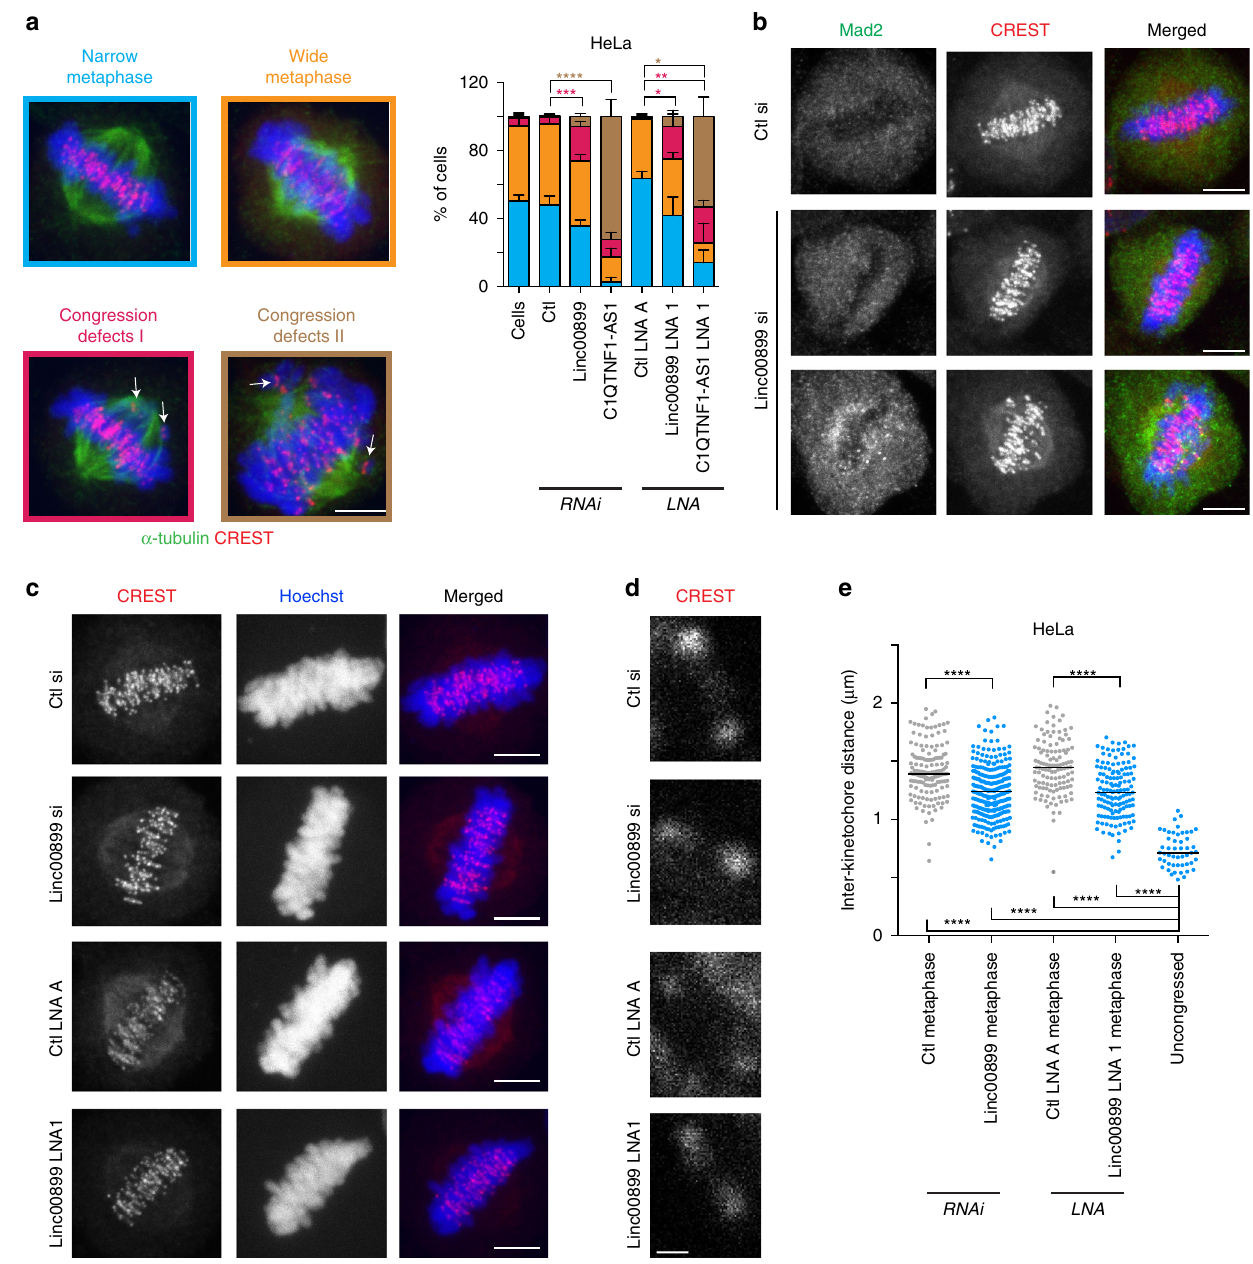
Fig. 6 Depletion of linc00899 causes chromosome congression defects. a Characterisation of mitotic phenotypes in HeLa cells after RNAi- and LNA- mediated depletion of linc00899 and C1QTNF1-AS1 . Percentage of mitotic cells with (i) narrow metaphase plate (blue), (ii) wide metaphase plate (orange), (iii) congression defect I (dark pink), and (iv) congression defect II (brown) using α -tubulin (microtubules, in green) and CREST (kinetochore marker, in red). Data are shown as mean ± S.E.M from at least three biological replicates, * P < 0.05, ** P < 0.01, *** P < 0.001 and **** P < 0.0001 by two-tailed Student ’ s t test. Scale bar, 5 µ m. b Mad2 is present on kinetochores of unaligned chromosomes in linc00899 -depleted mitotic cells. Representative images of metaphase cells after RNAi-mediated depletion of linc00899 . Cells were stained for Mad2 (SAC protein, in green) and with CREST (red). In cells treated with negative control siRNA (Ctl), Mad2-positive kinetochores were detectable in 20% of cells with narrow metaphase plates, whereas this fi gure was 12% in linc00899 -depleted cells. In all, 89% of linc00899 -depleted cells with congression defects were positive for Mad2. DNA was stained with Hoechst and is shown in blue in the merged images. Scale bar, 5 µ m. c Representative images representing maximum intensity projections of interkinetochore (inter-KT) distance in HeLa cells after RNAi- and LNA-mediated depletion of linc00899 . Cells were stained with CREST (red) and Hoechst (blue). Scale bar, 5 µ m. d Insets show examples for individual KT pairs from single focal planes based on CREST staining. Scale bar, 0.5 µ m. e Quanti fi cation of inter-KT distance in cells after linc00899 depletion as in c . A total of 152, 270, 121, 140 and 50 kinetochore pairs (from left to right; at least 7 pairs per cell) were measured for each condition. Numbers of metaphase cells analysed is n = 18 for Ctl si, n = 26 for linc00899 RNAi, n = 14 for Ctl LNA A, n = 13 for linc00899 LNA1, and n = 15 for cells with uncongressed chromosomes from linc00899 -depleted cells. For each condition, we show the median with interquartile range. **** P < 0.0001 one-way ANOVA test. Source data are provided as a Source Data fi